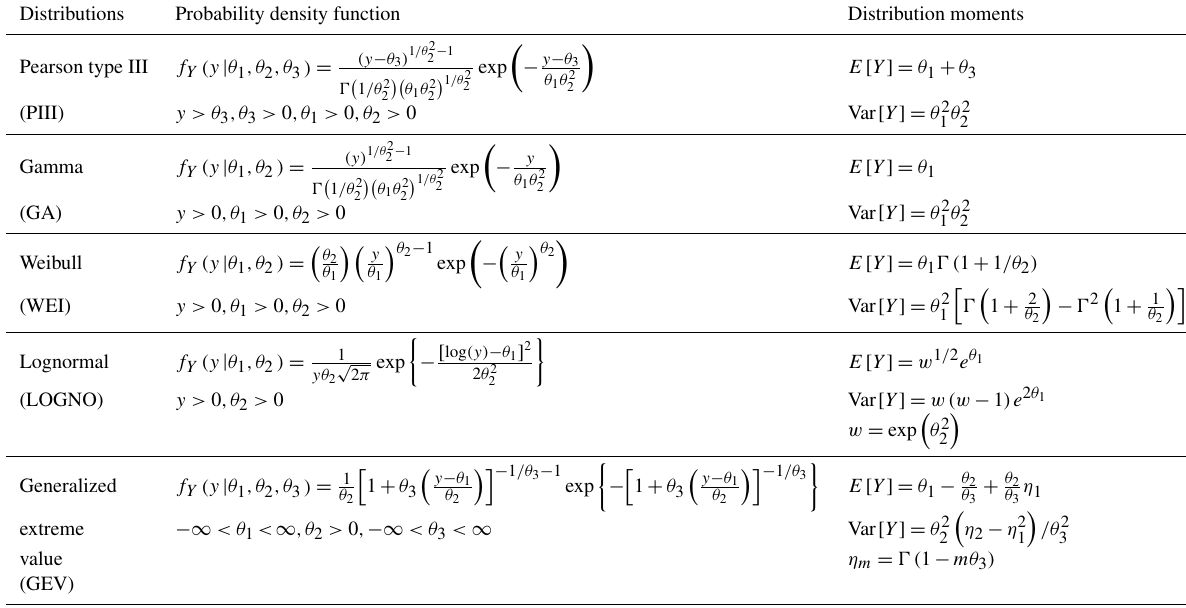
Table 1. The probability density functions and moments (the mean and variance) for the candidate distributions in this study. Distributions